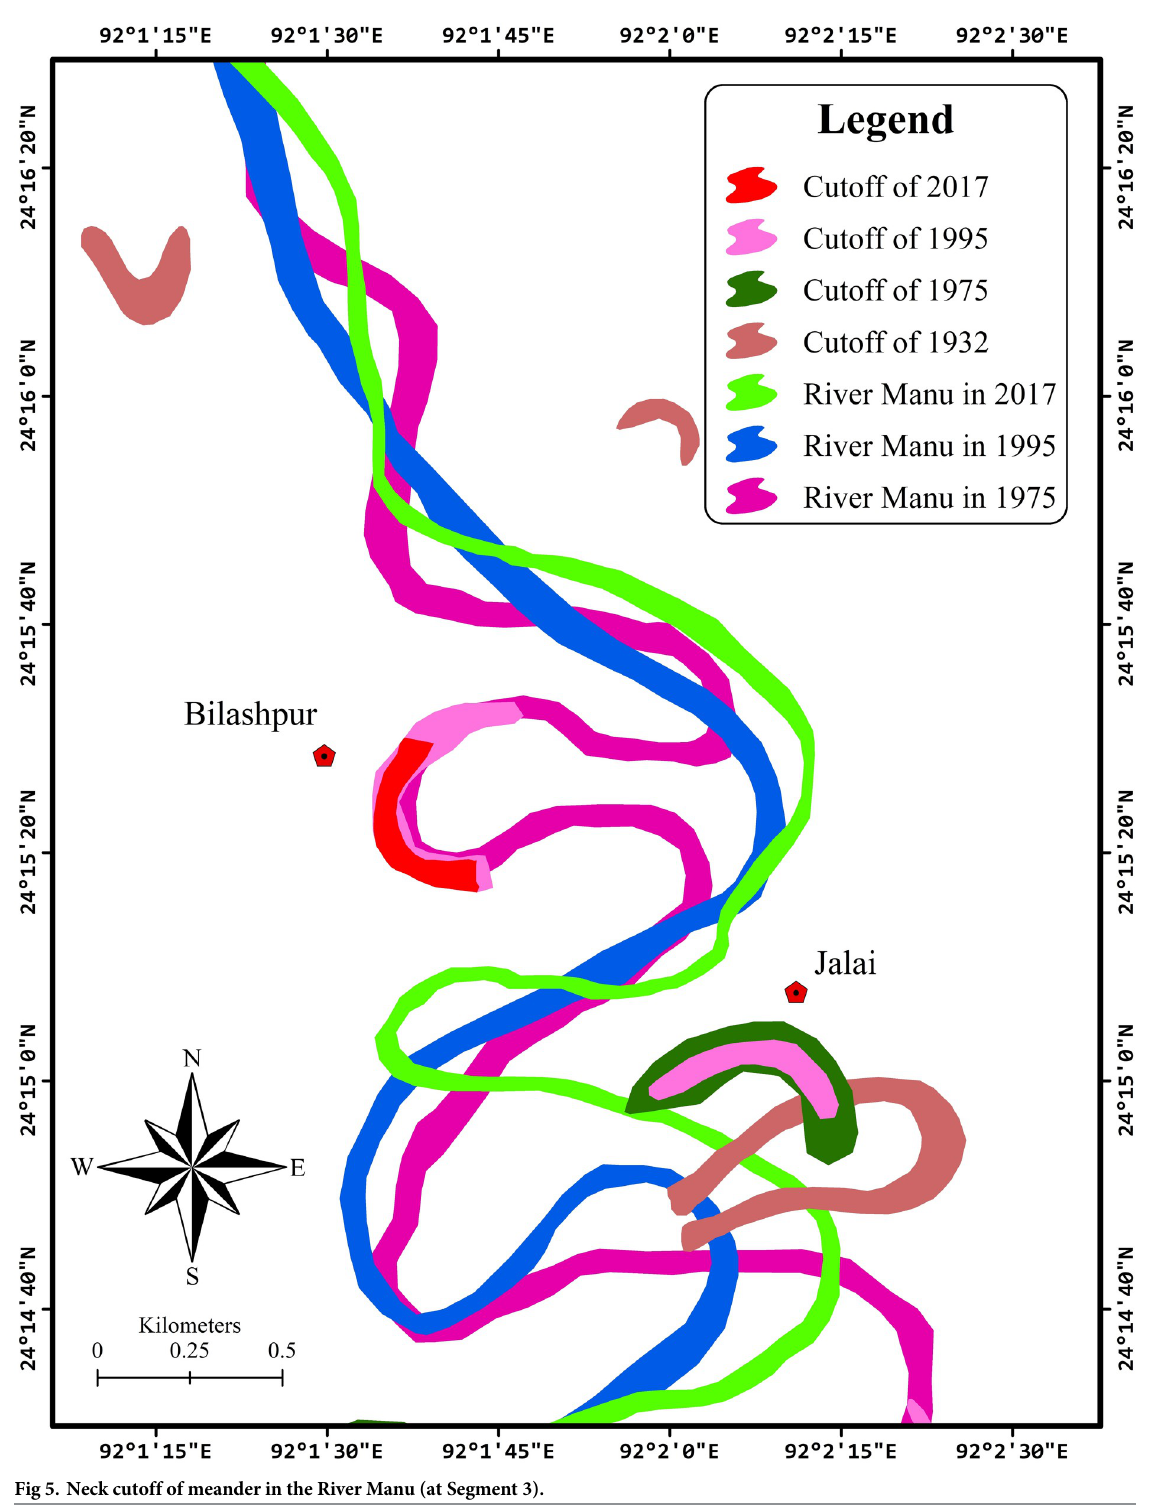
Fig 5. Neck cutoff of meander in the River Manu (at Segment 3).